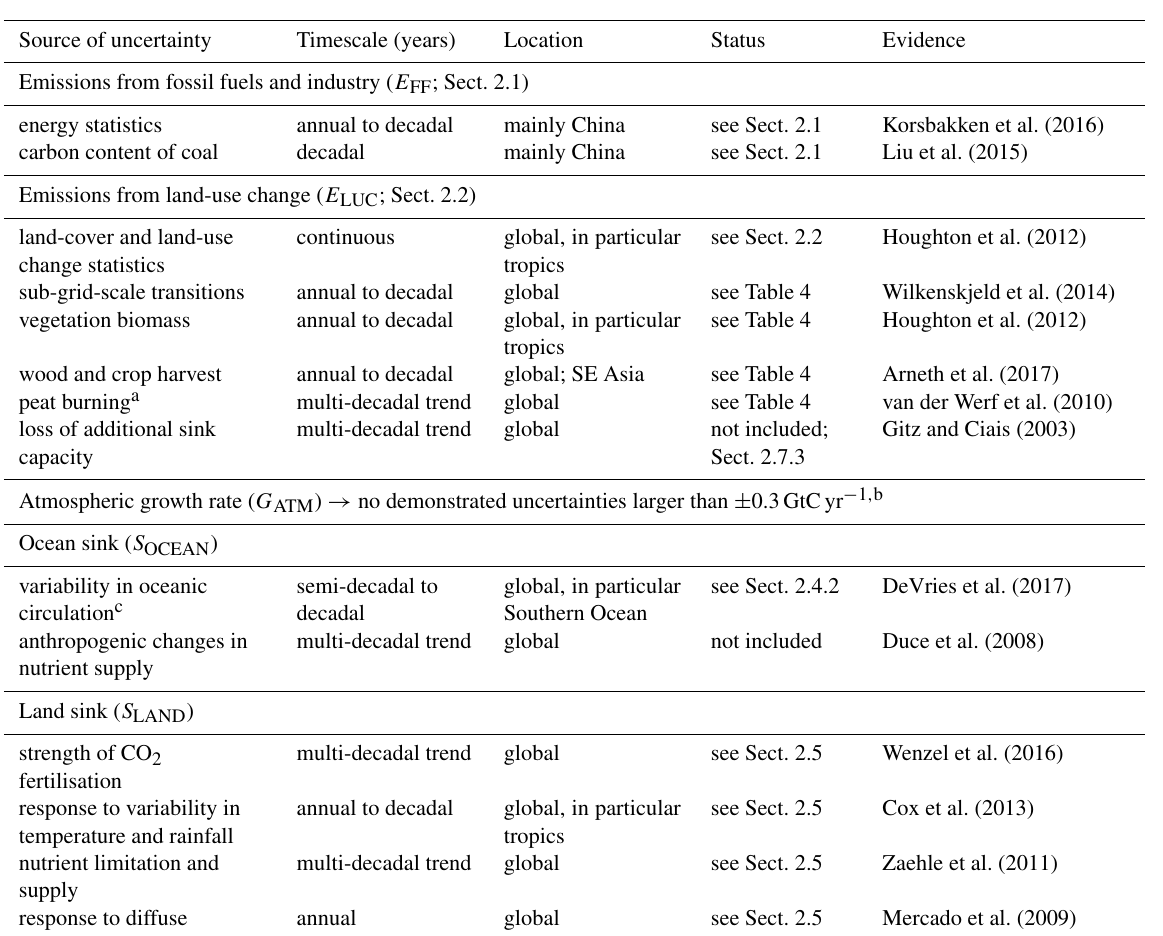
Table 9. Major known sources of uncertainties in each component of the global carbon budget, defined as input data or processes that have a demonstrated effect of at least 0.3GtCyr − 1